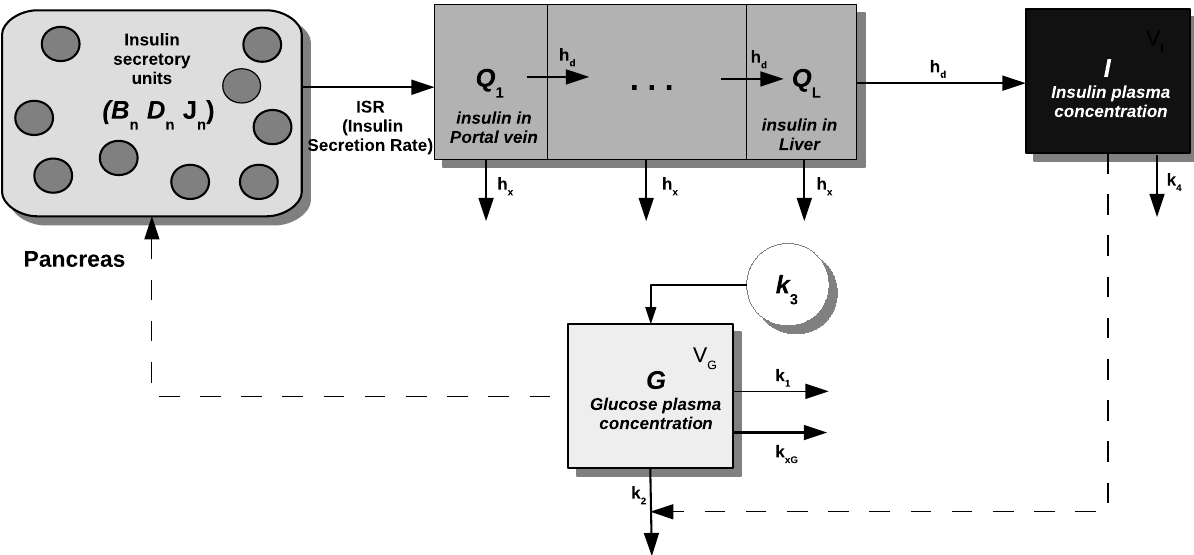
Fig 2. Schematic representation of the Extended Model . The pancreas secretory units (circles) release at different times their packet of insulin J n ( t ) ( t ) and on the potentiation level D ( t )) in such a way that at any given time a total quantity J ( t ) (depending, for the n -th controller, on the threshold B n n (sum of the amounts J n ( t )) of insulin flows into the portal vein ( Q 1 compartment), then to the liver ( Q i +1 ... Q L compartments) and finally reaching the plasma (compartment I ), stimulating the uptake of glucose by tissues. Glycemia ( G compartment), which is raised by glucose hepatic production k 3 , stimulates the production of insulin, closing the